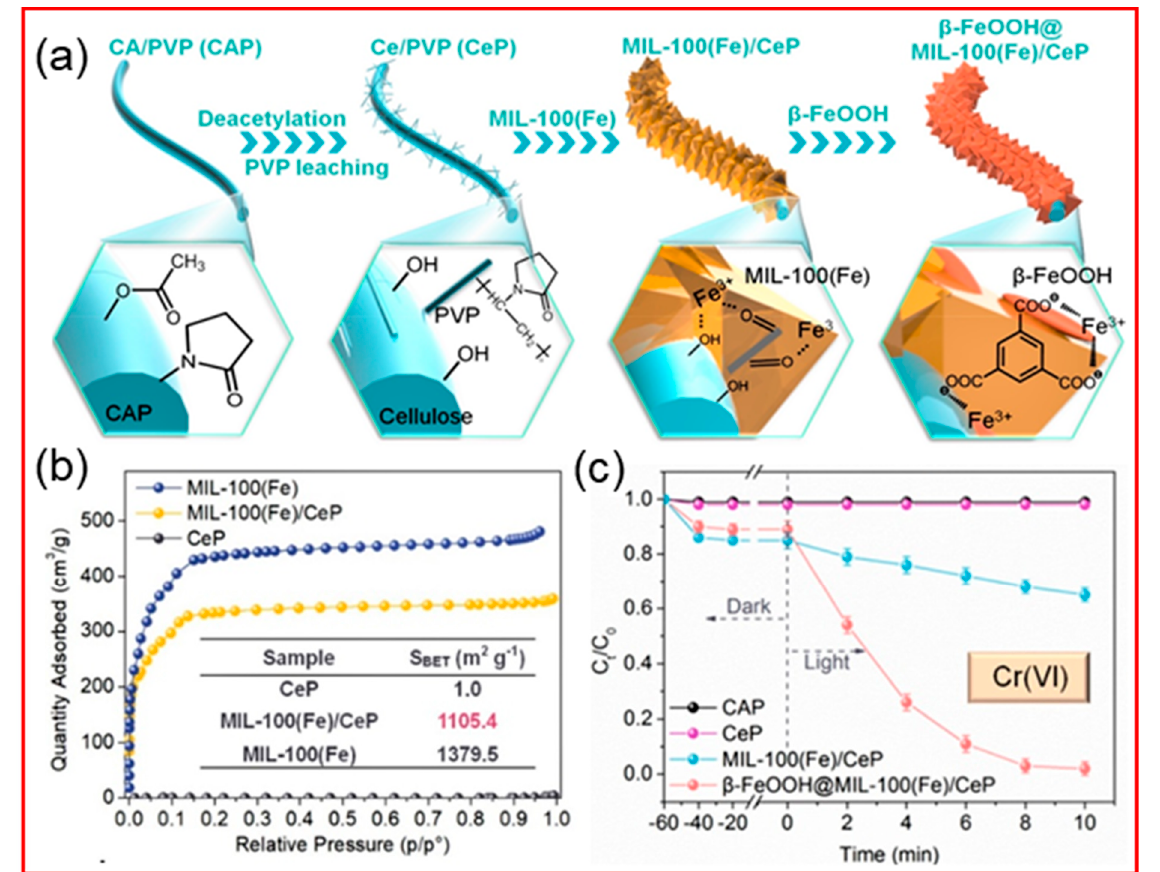
Figure 12. ( a ) Schematic of the preparation of porous core sheath β − FeOOH@MIL − 100(Fe)/CeP NFM; ( b ) N 2 adsorption isotherms of MIL − 100(Fe) and MIL − 100(Fe)/CeP NFM and pore structure parameters (inset); ( c ) In the presence of CeP, CAP, and under visible light irradiation, the MIL − 100(Fe) and MIL − 100(Fe)/CeP NFM photocatalytic activity curves for Cr(VI) in the presence of CeP, CAP [156].